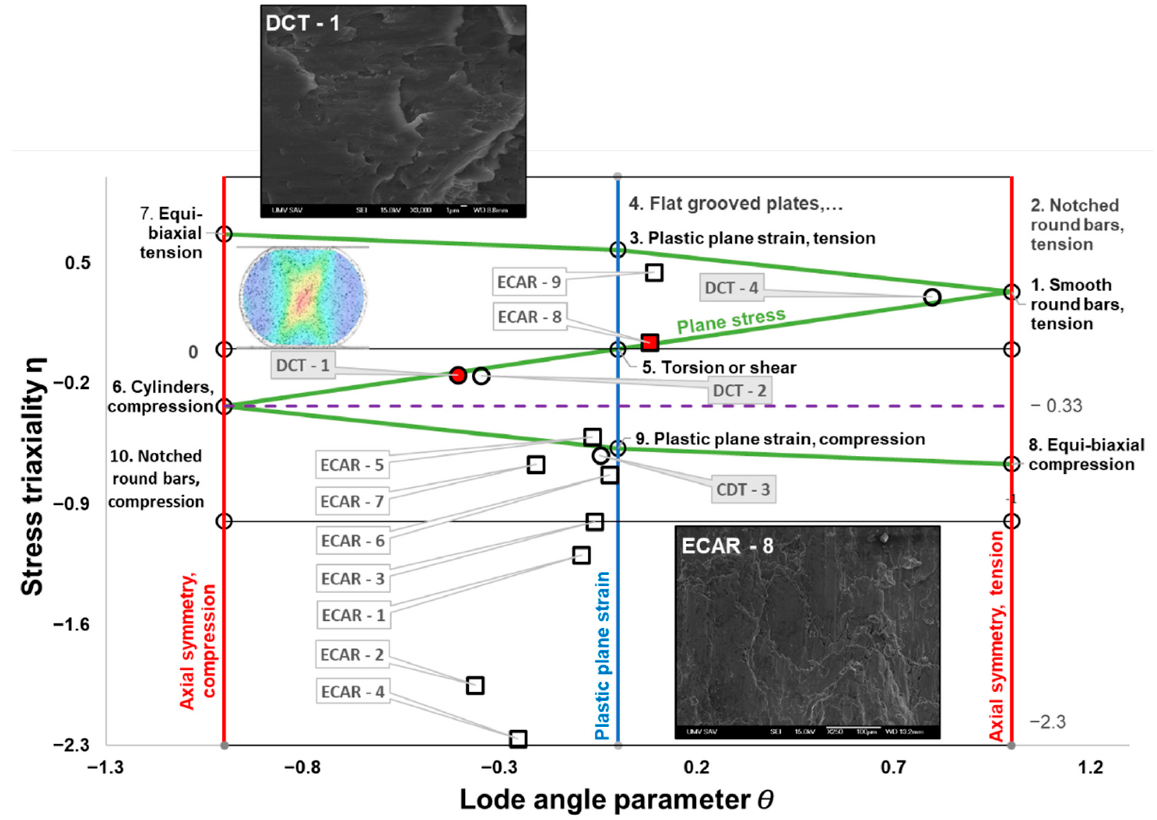
Figure 9. The stress state diagram shows the relationship between failure mode and stress state for the conditions of the ECAR process and the DC test.